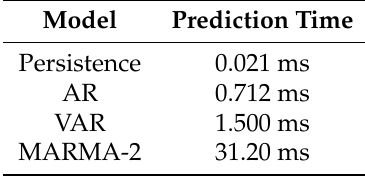
Table 5. The execution times of the used and the proposed models in milliseconds